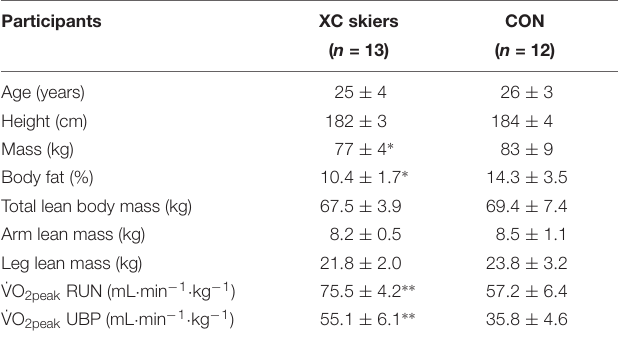
TABLE 1 | Anthropometric and physiological characteristics of the elite cross-country (XC) skiers and the physically active control group (CON) of this study (means ±